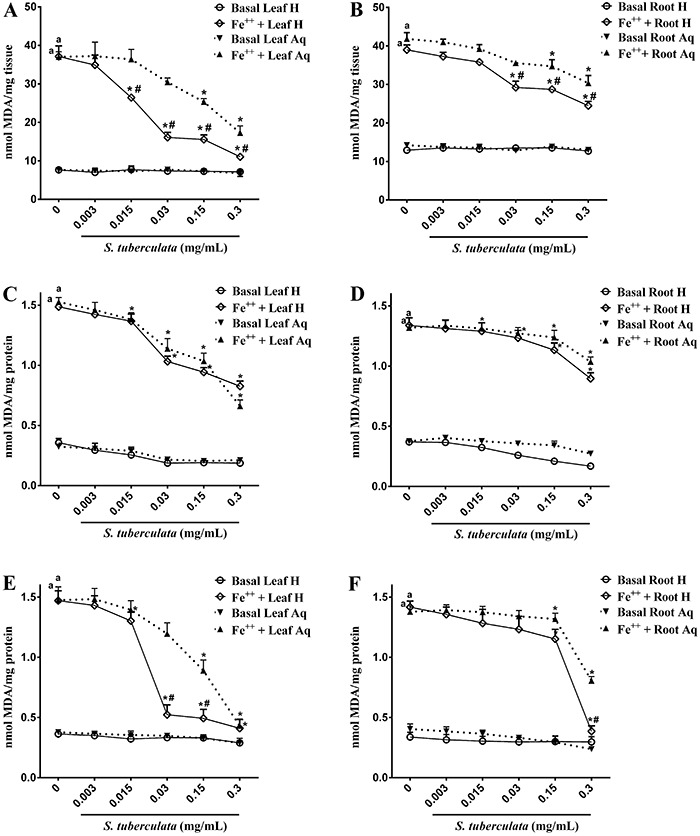
Effects of S. tuberculata extracts on TBARS production in egg yolk lipids (A, B), brain (C, D) and liver (E, F) of rats. Hydroethanolic leaf extract (Leaf H), aqueous leaf extract (Leaf Aq), hydroethanolic root extract (Root H), and aqueous root extract (Root Aq) were evaluated. Results are reported as nmol of MDA per mg of tissue (A, B) or mg of protein (C-F) for (n=3). aP≤0.05 compared to basal not induced (i.e., zero concentration); *P≤0.05 compared to basal in the same group (i.e., zero concentration); #P≤0.05 compared to the same concentration of the other extracts evaluated (two-way ANOVA with the Tukey's post tests).